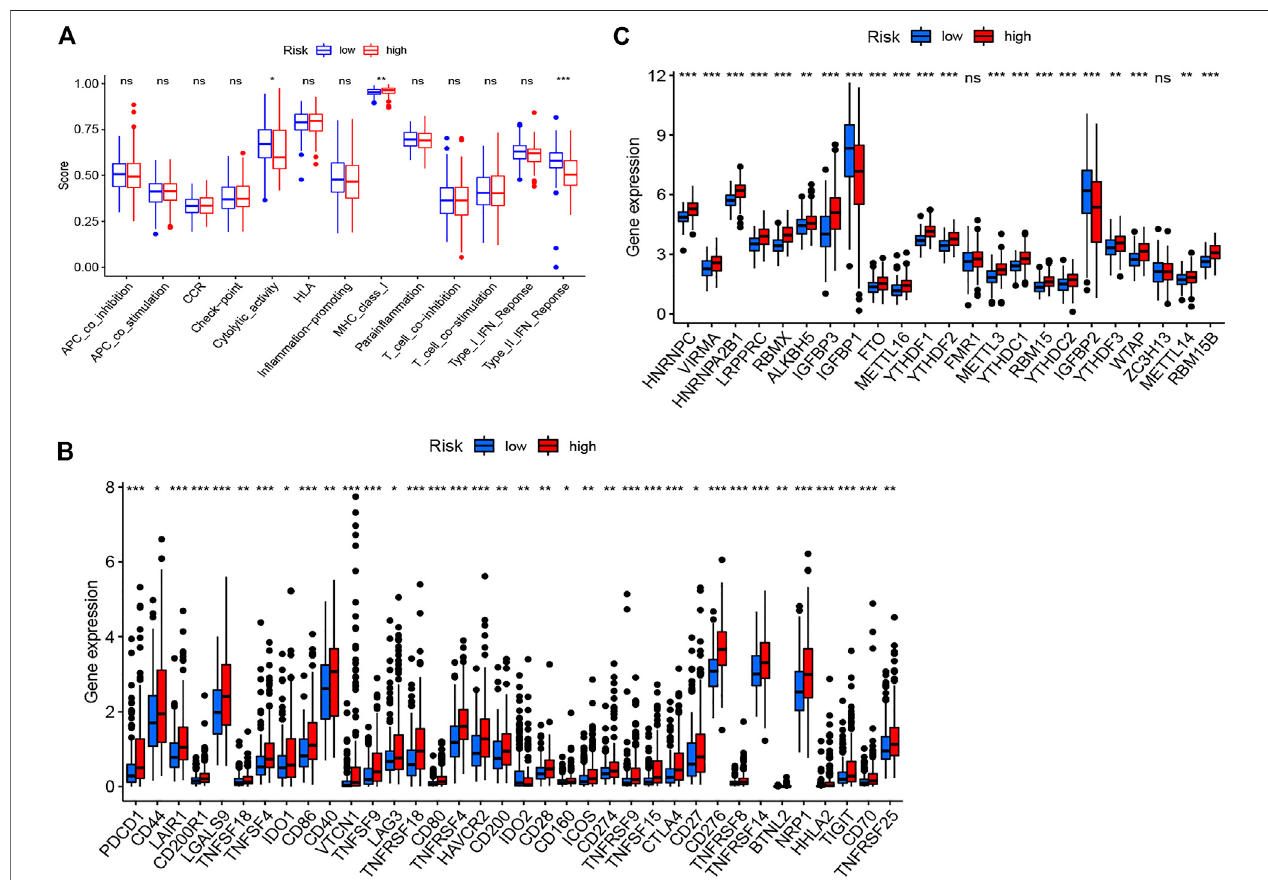
FIGURE 9 | The immune cells related functions (A) , immune checkpoints (B) and m6A-related genes (C) between two risk groups.